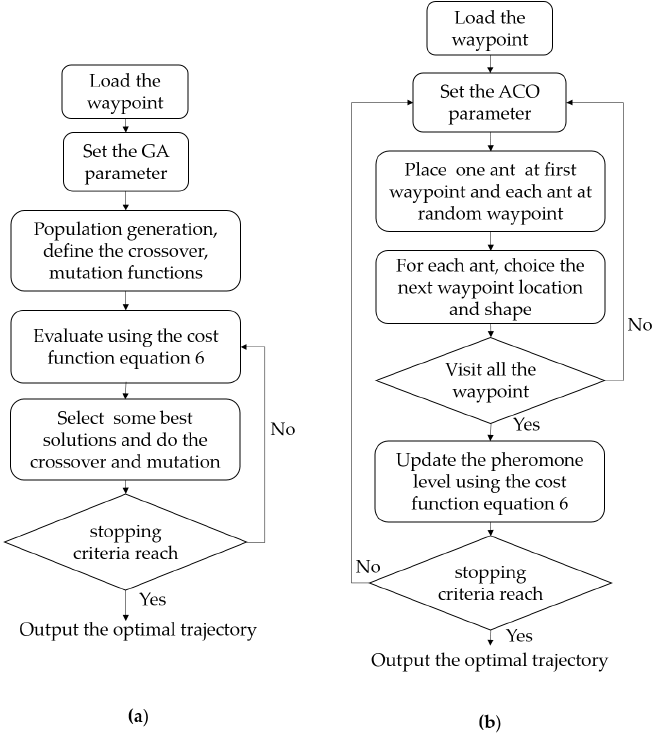
Figure 12. Block diagram for GA- and ACO-based TSP algorithms: ( a ) GA; and ( b ) ACO.